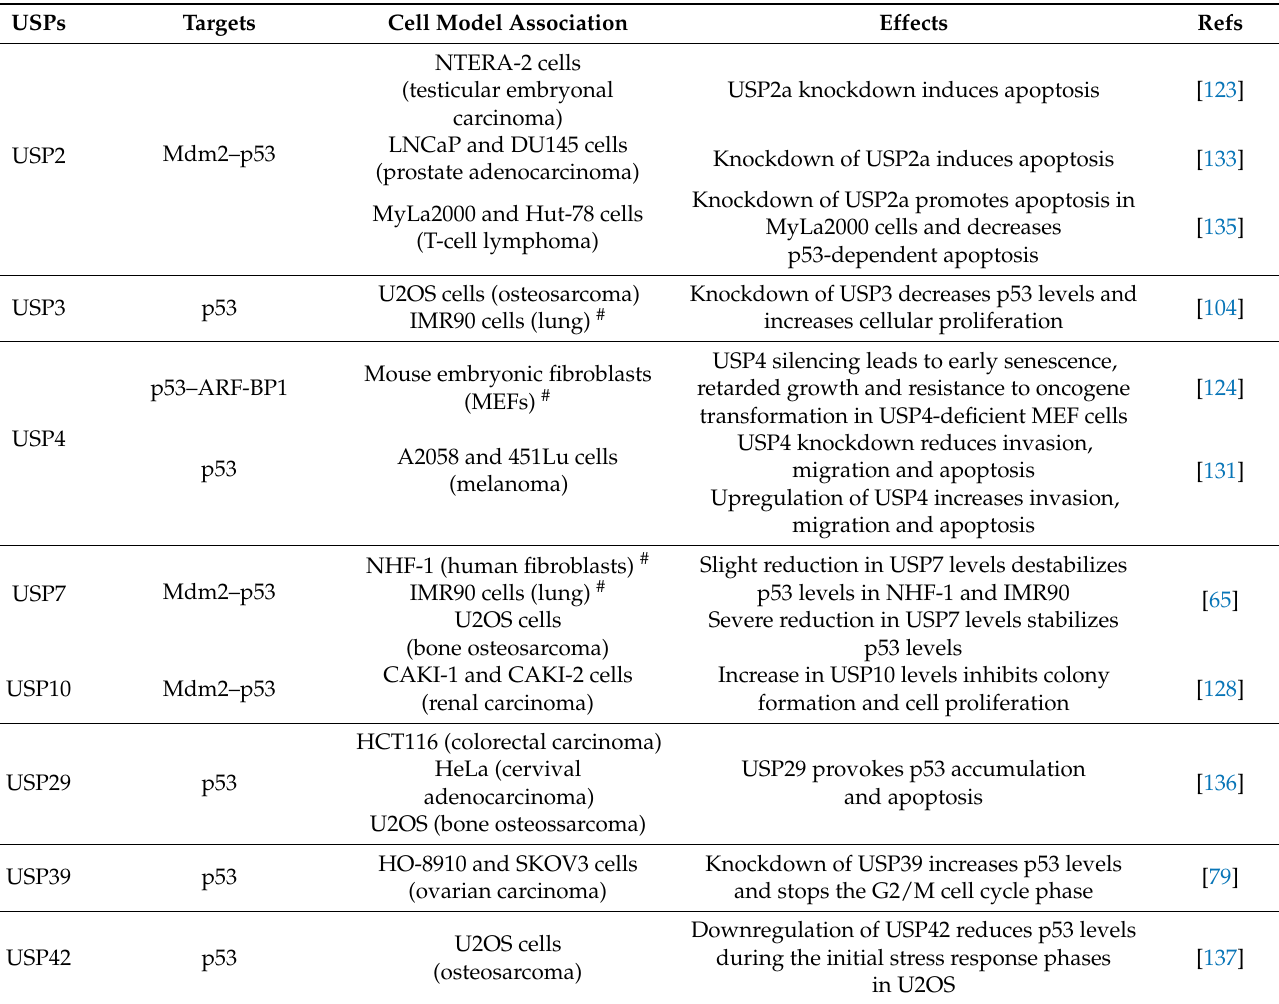
Table 4. Summary of cellular consequences resulting from interactions between different USPs and target proteins associated with the p53 signaling